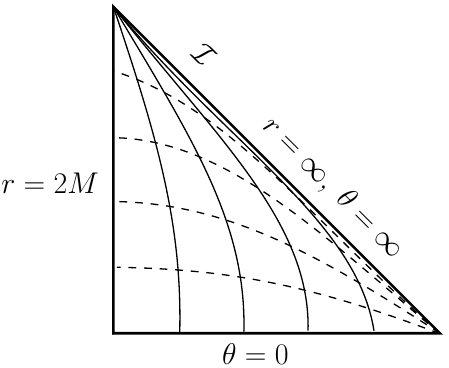
Figure 4. The toric Penrose diagram for (2 , 2) Schwarzschild. Lines of constant r are solid, and lines of constant θ are